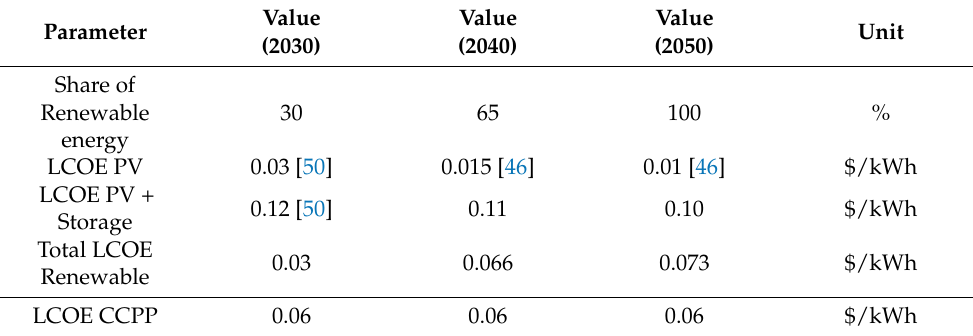
Table 4. Variation in the energy mix and assumed Levelized Cost of Energy